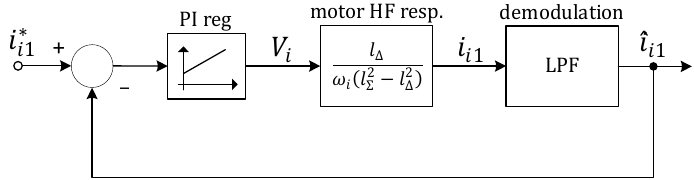
Figure 6. Regulation loop for anisotropy-related current magnitude: equivalent dynamics schematic.